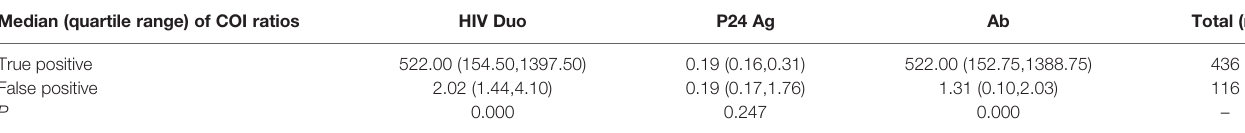
TABLE 2 | Median (quartile range) of cutoff index (COI) ratios of all 522 WB or subsequent supplement detections con fi rmed individuals. Median (quartile range) of COI